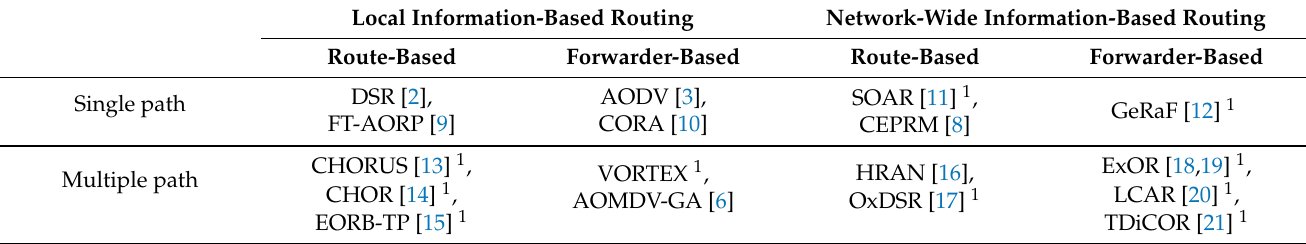
Table 1. Routing protocols for multi-hop